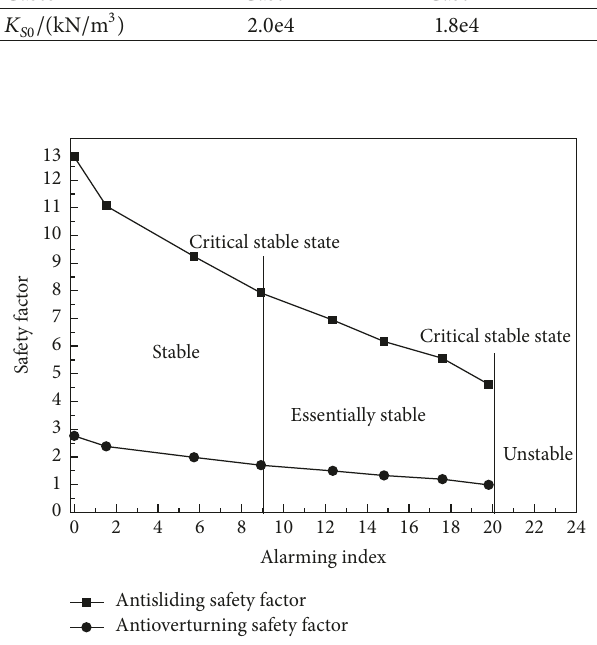
Figure13:Curveofalarmingindex-damagestabilityoftheretaining wall (damage in the anchoring